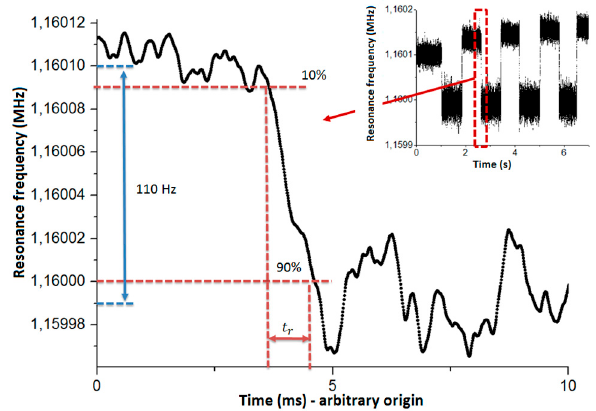
Figure 9. Resonance frequency according to the acquisition time. A 1 mW red laser is focalized onto the pixel under test (typical Figure 3c). Insert: Full data from our measurement of response time. The average frequency jump is estimated as 110 Hz. Then, the response time is extracted from one event fall time (red).